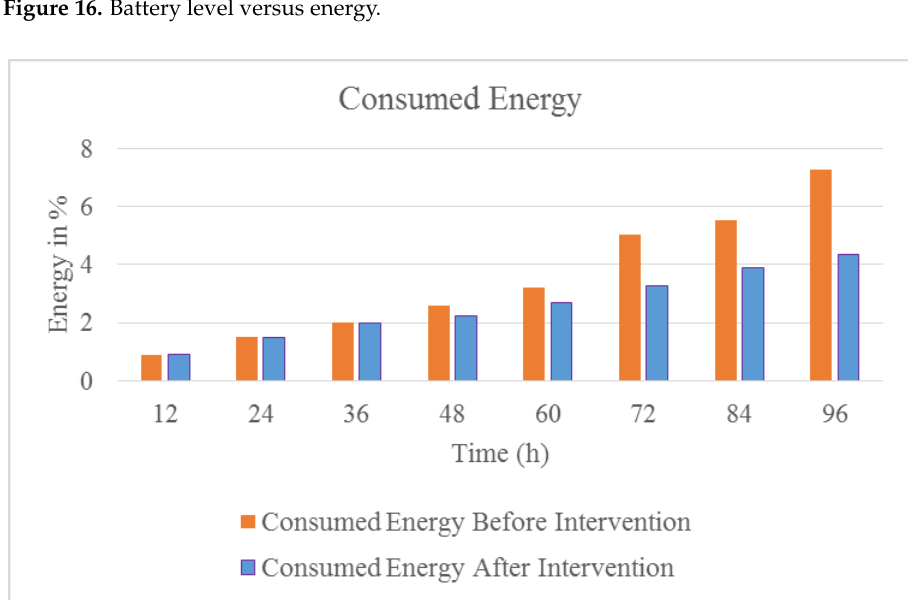
Figure 17. Energy consumption.